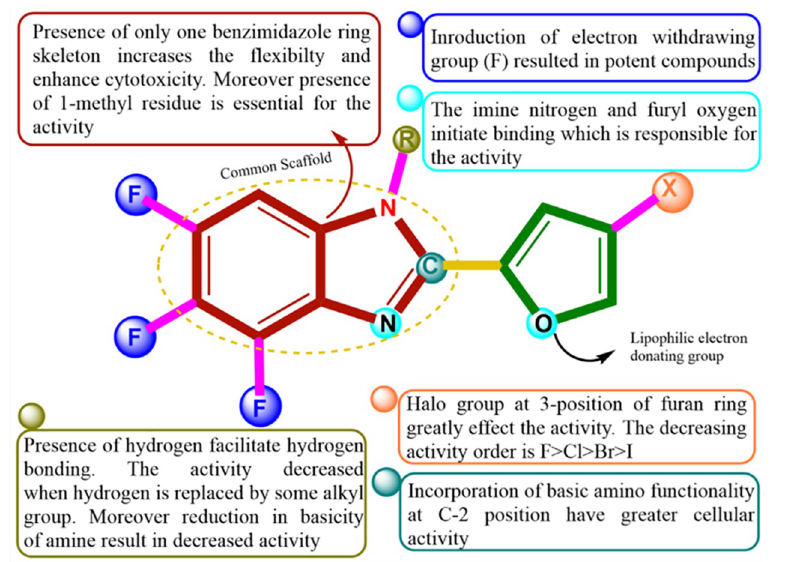
Fig 6. Display of structure-activity relationships in studied compounds.